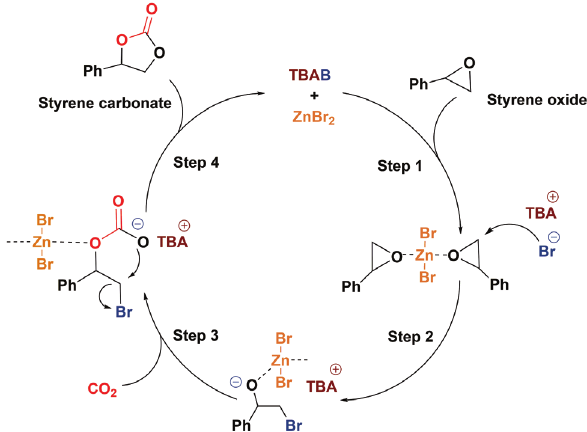
Figure 14: Proposed mechanism of styrene carbonate (SC) formation from styrene oxide (SO) and CO